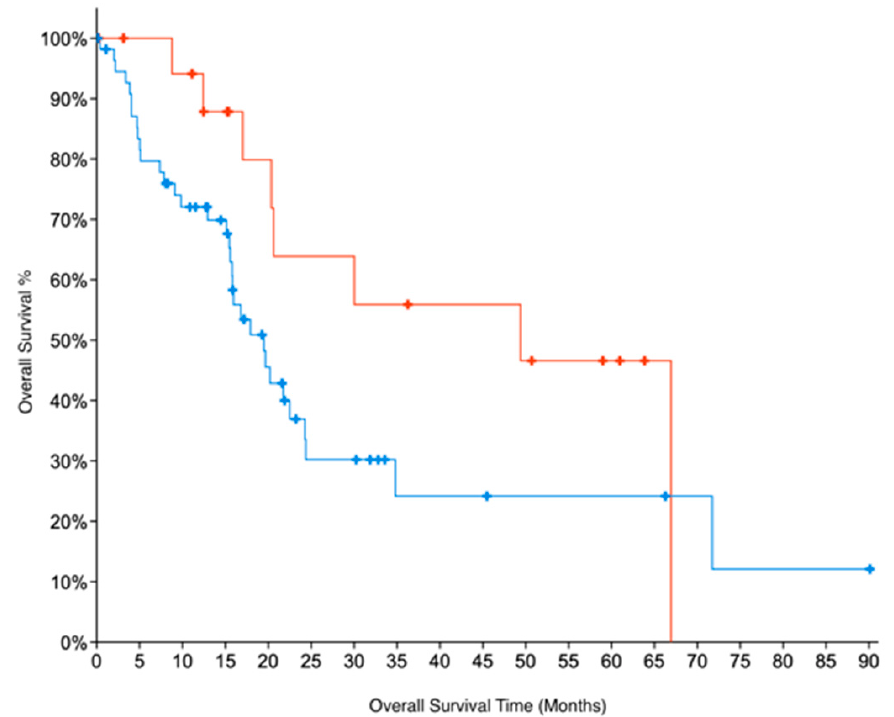
Figure 3. Kaplan–Meier survival curves for patients in Grade 1 (early-stage, well-differentiated) PC. Absence of deletions in GNMT (Red curve) is associated with better Overall Survival prognosis (log-rank test p -value = 0.08), when compared to (all) PC patients with deletions in GNMT (Blue curve).